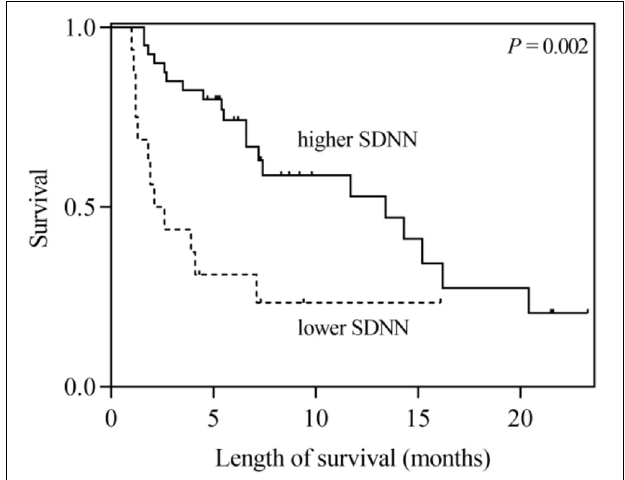
FIGURE 2 | Kaplan–Meier survival curves for LCBM patients with RMSSD ≤ 4.8 ms versus those with RMSSD > 4.8